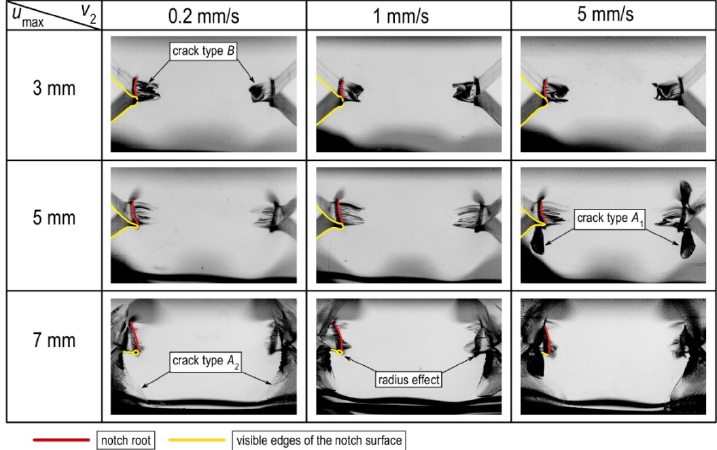
Figure A3. Deformation in the rounded V-notched specimens ( t 2 ) after the unloading for u max = 3, 5, and 7 mm and (cid:2013)̇ (cid:2870) 8 × 10 −3 , 4 × 10 −2 , and 2 × 10 −1 s −1. Materials 2020 , 13 , x FOR PEER REVIEW 2 8